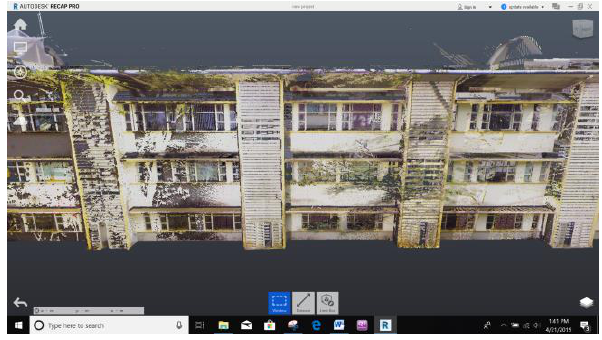
Figure 8 Example of unwanted point clouds in the study